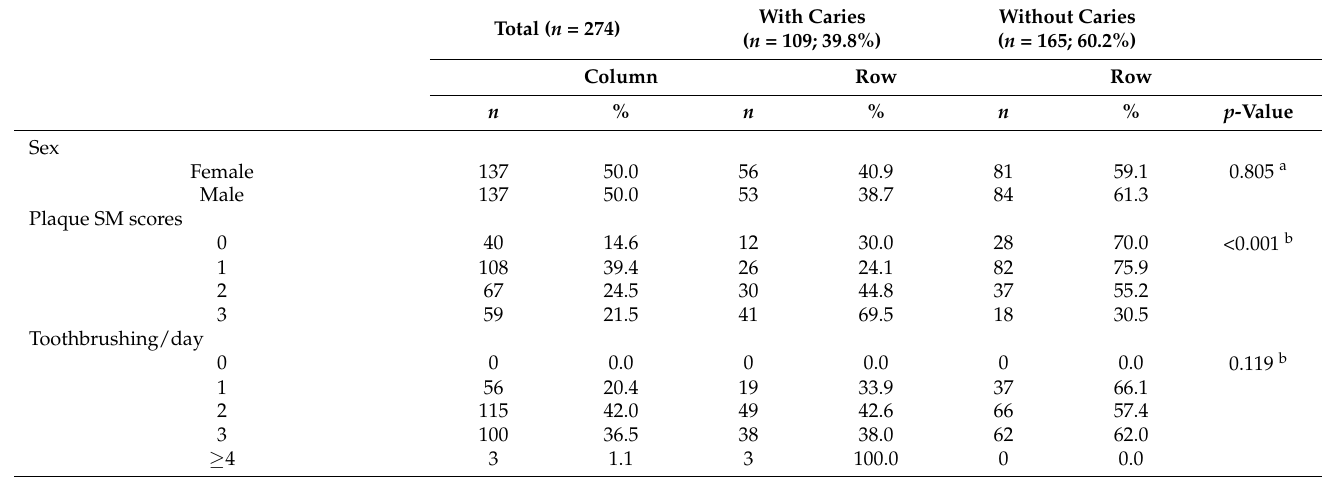
Table 1. Participant characteristics and comparisons between children with and without caries. With Caries Total ( n = 274) ( n = 109;